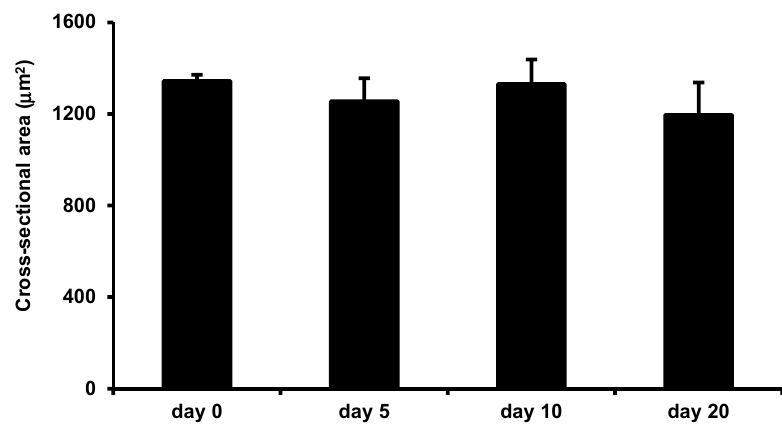
Figure 7. Low-intensity vibration does not enhance myofiber size in uninjured mice. Uninjured control mice were subjected to the LIV protocol and gastrocnemius muscles were collected at the indicated time points. Average cross-sectional area of individual myofibers was quantified in five 40 × fields per muscle in hematoxylin and eosin-stained sections. Data are presented as mean ± SE.